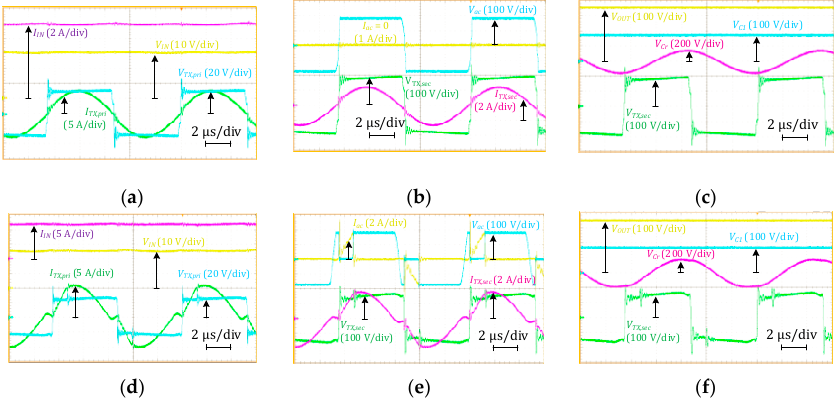
Figure 8. Steady-state experimental waveforms of the proposed converter operating at ( a – c ) P IN = 300 W, V IN = 30 V, D b = 0, and ( d – f ) P IN = 300 W, V IN = 25 V, D b = 0.215.